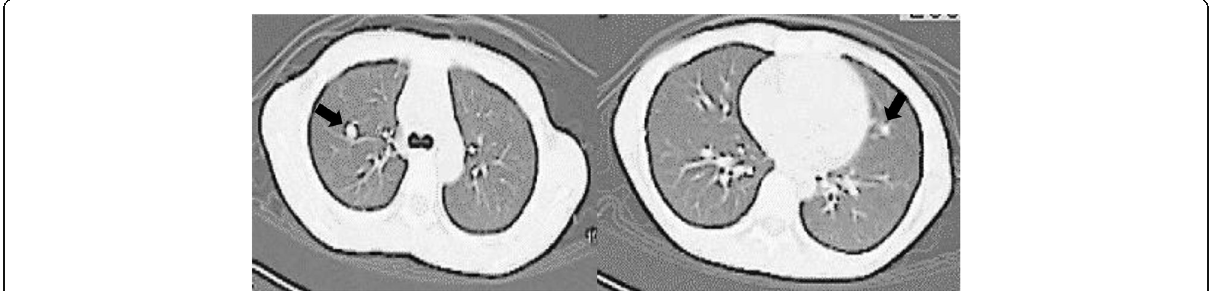
Fig. 2 Chest plain computed tomography scan showed pulmonary nodular shadows of the S1 region in the right lung and lingular region in the left